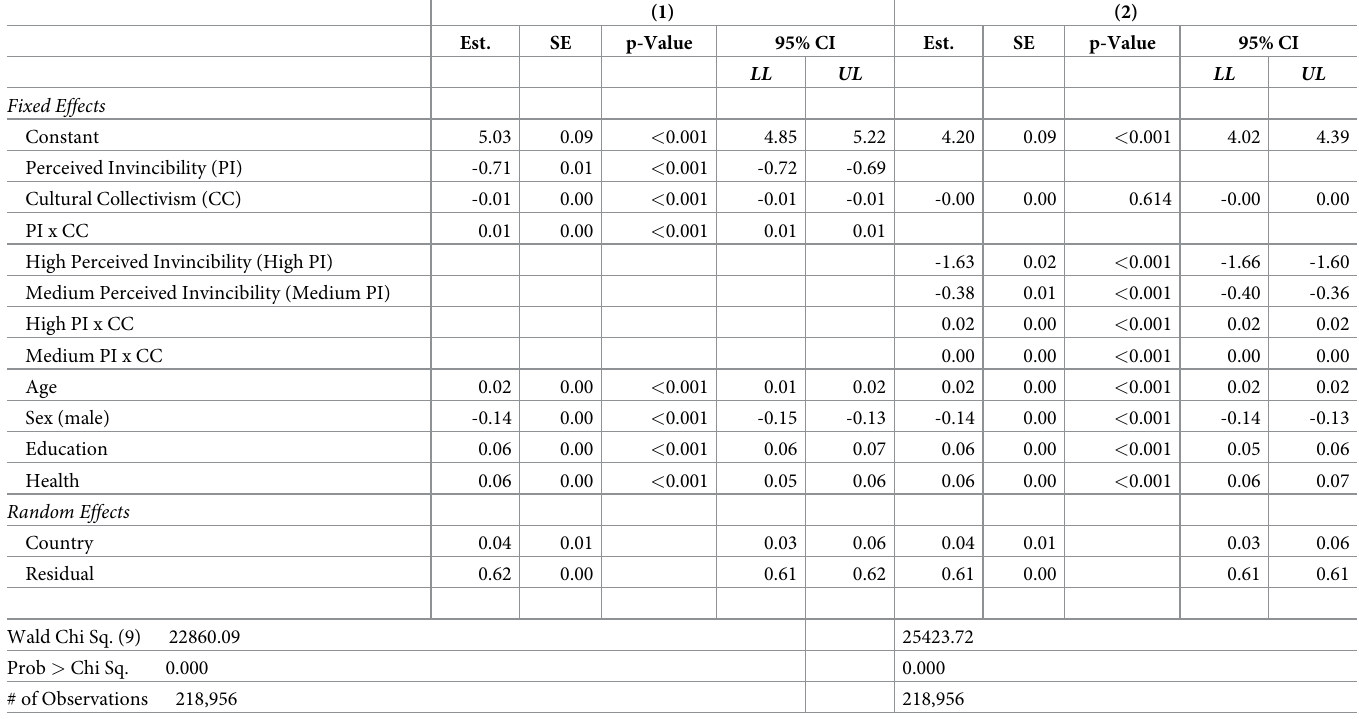
Table 1. Linear mixed model results for the effects of perceived invincibility and cultural collectivism on prosocial